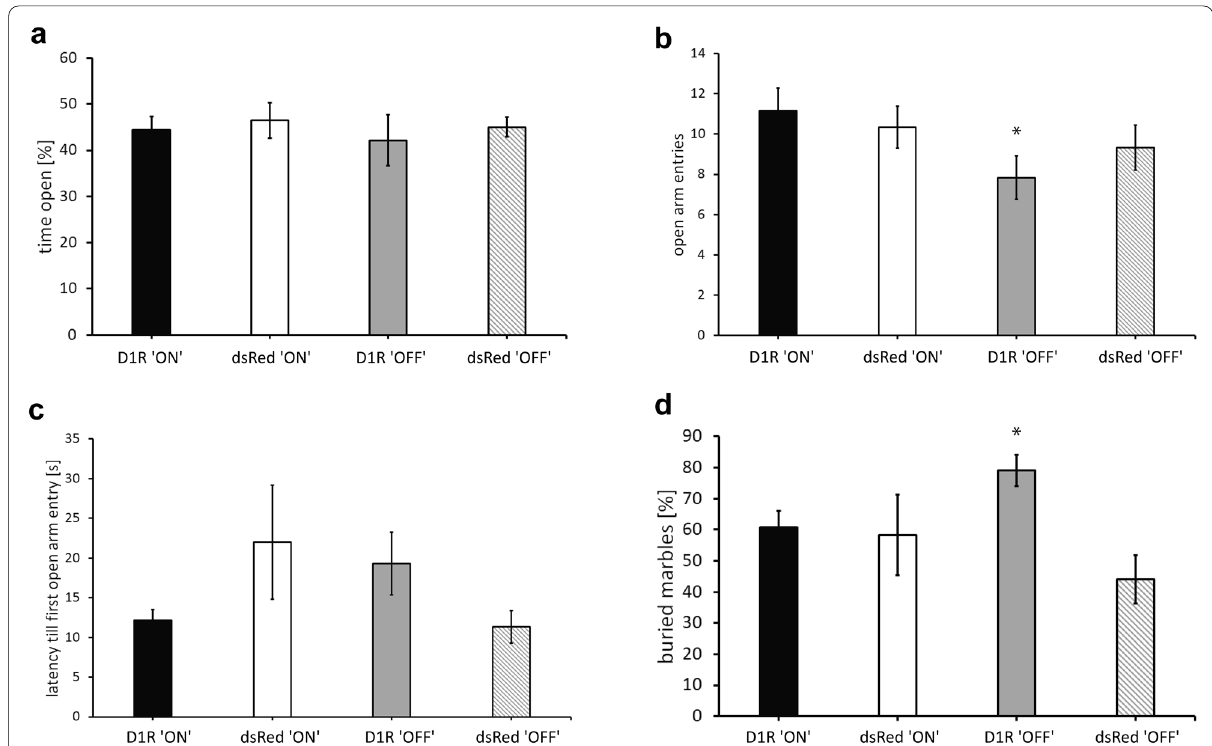
Fig. 2 Anxiety behavior and compulsive activity accessed in the Elevated Plus Maze and Marble Burying paradigm indicated through time in open arm, open arm entries, latency till first open arm entry and amount of buried marbles. Virus over-expression (‘ON’) is terminated (‘OFF’) following doxycycline removal. a Anxiety as measured time spent in the open arm [%]. b Anxiety behavior was also determined as number of open arm entries. c Risky behavior as measured as latency till first open arm entry. d D1R ‘OFF’ animals buried significantly more marbles than their control group (dsRed ‘OFF’) and D1R ‘ON’ subjects. Means SEM are presented for n 6 subject for each group. *Represent p < 0.05 Bonferroni correction ± = indicating significant differences between relevant